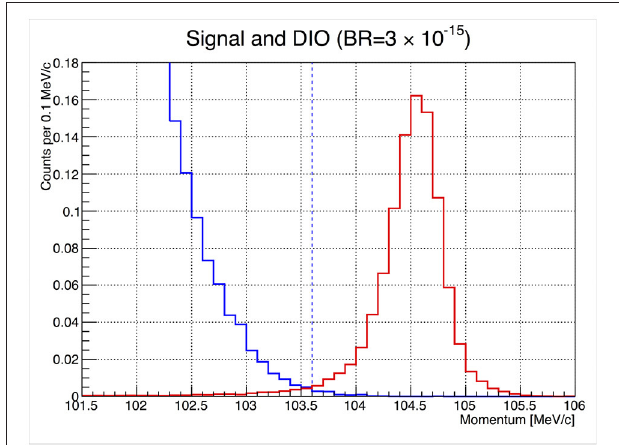
FIGURE 7 | The momentum distributions for the reconstructed µ − e conversion signals (right solid red curve with peaking distribution) and reconstructed DIO events (left solid blue curve with decreasing distribution). The vertical scale is normalized such that the integral of the signal curve is equal to one event. This assumes a branching ratio of B ( µ N → eN ) = 3.1 × 10 − 15